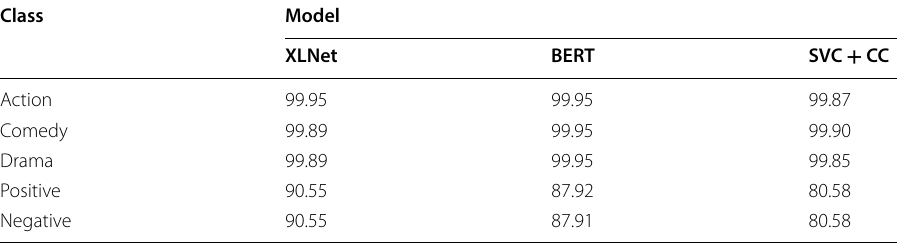
Table 13 Class based accuracy of the top-five classes in the RT dataset